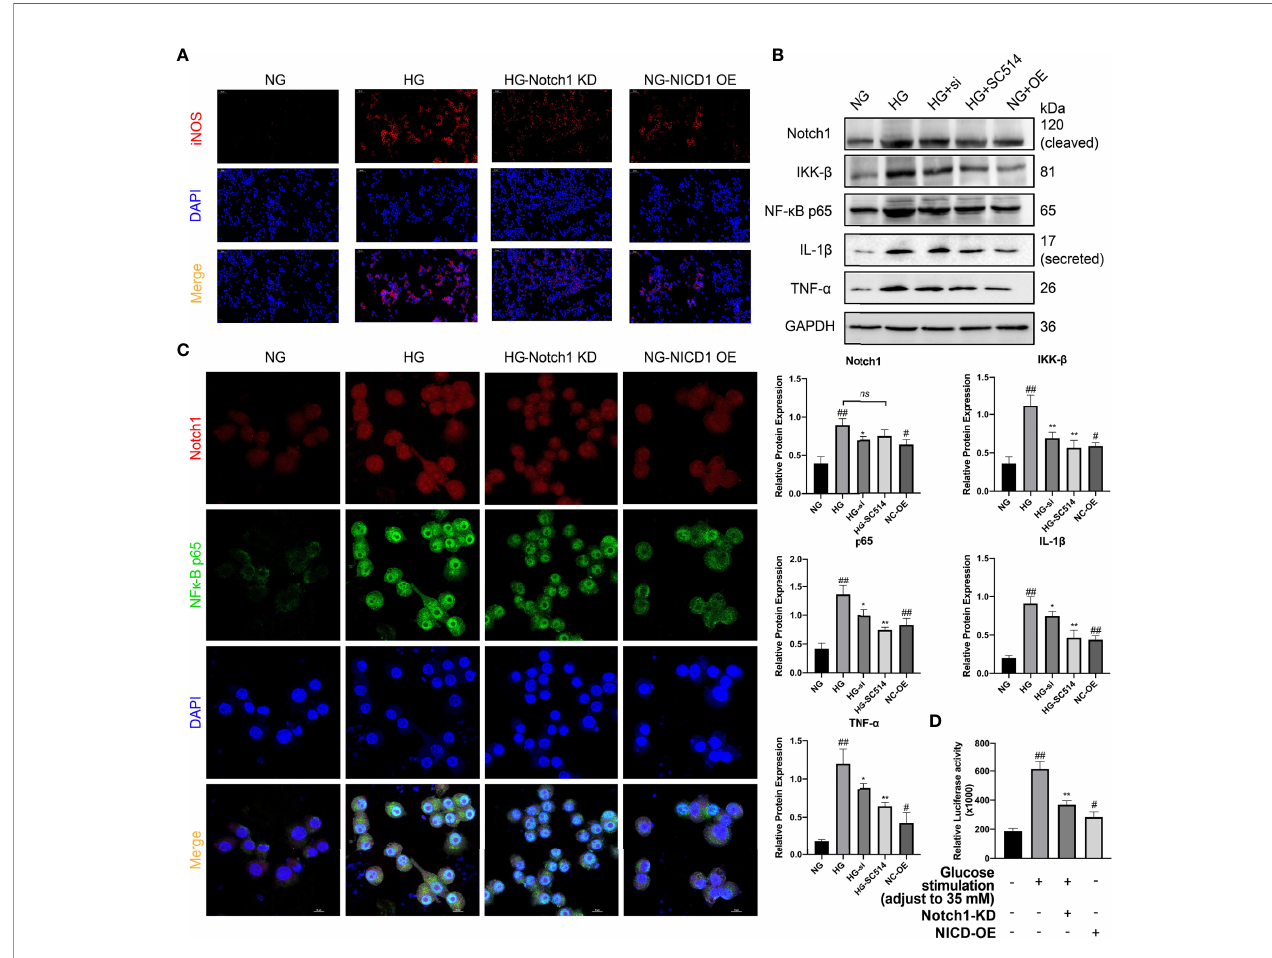
FIGURE 7 | Activation of the Notch signaling pathway plays a crucial role in the M1 polarization of macrophages in HG stimulation. (A) Immuno fl uorescence (IF) of inducible nitric oxide synthase (iNOS). (B) Western blot and semiquantitative analyses. (C) Confocal microscopy analysis of Notch1 and NF- k B p65 co-IF staining, magni fi cation: 1000×. (D) Luciferase Activity of NF- k B-responsive luciferase reporter gene in HG stimulated Raw 264.7 cells. NG, normal glucose; HG, high glucose; Notch KD/si, Notch1 Knockdown; NICD-OE, NICD over expression. # p < 0.05 vs. the normal glucose (NG) group, ## p < 0.05 vs. the normal glucose (NG) group. *p < 0.05 vs. the high-glucose (HG) group, **p < 0.01 vs. the high-glucose (HG) group. ns, no signi fi